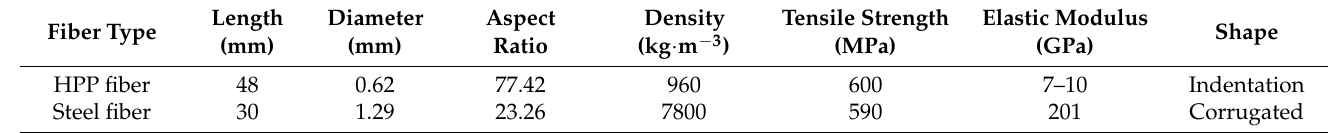
Table 1. Physical properties of